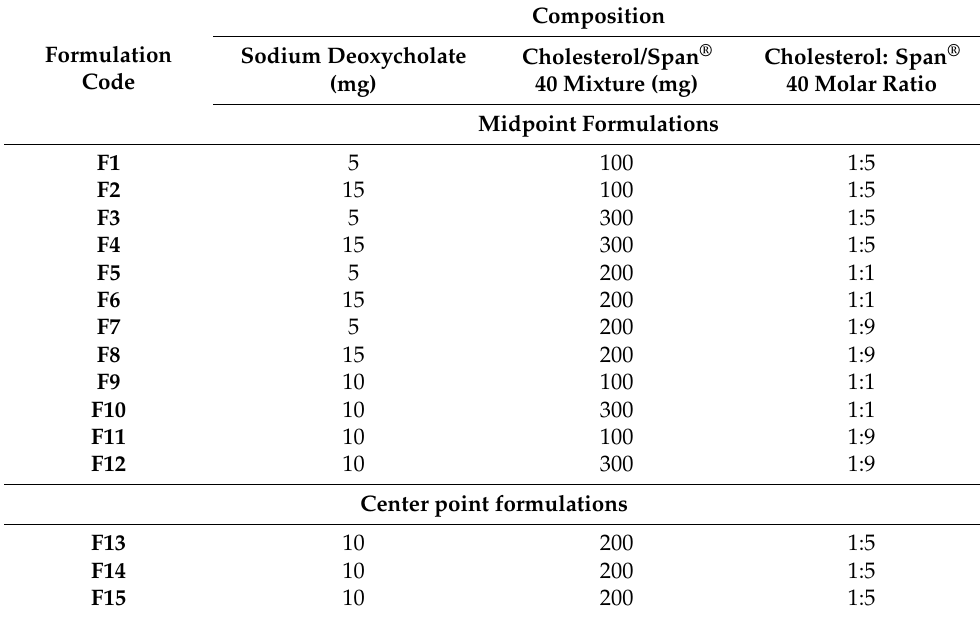
Table 2. Composition of the prepared zolmitriptan-loaded bilosomes.